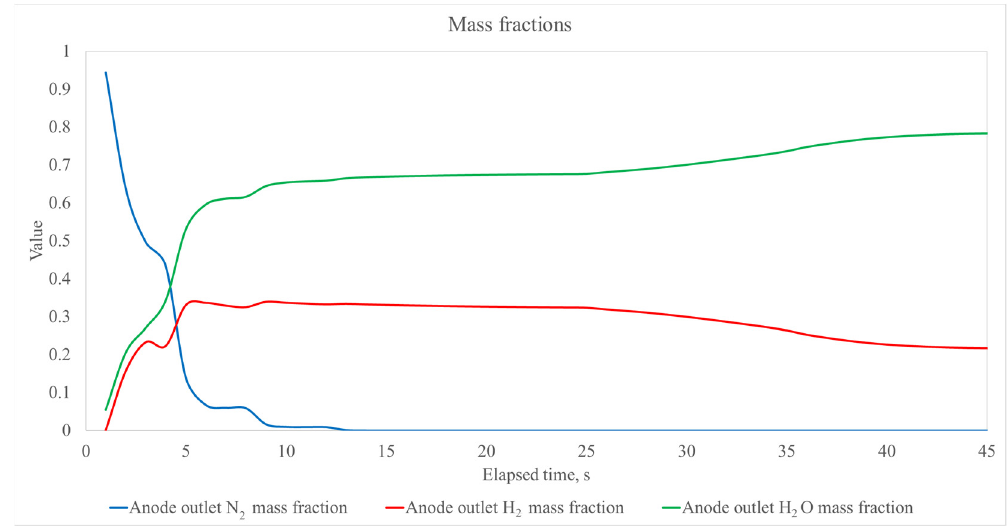
Figure 8. Anode outlet species mass fraction history.